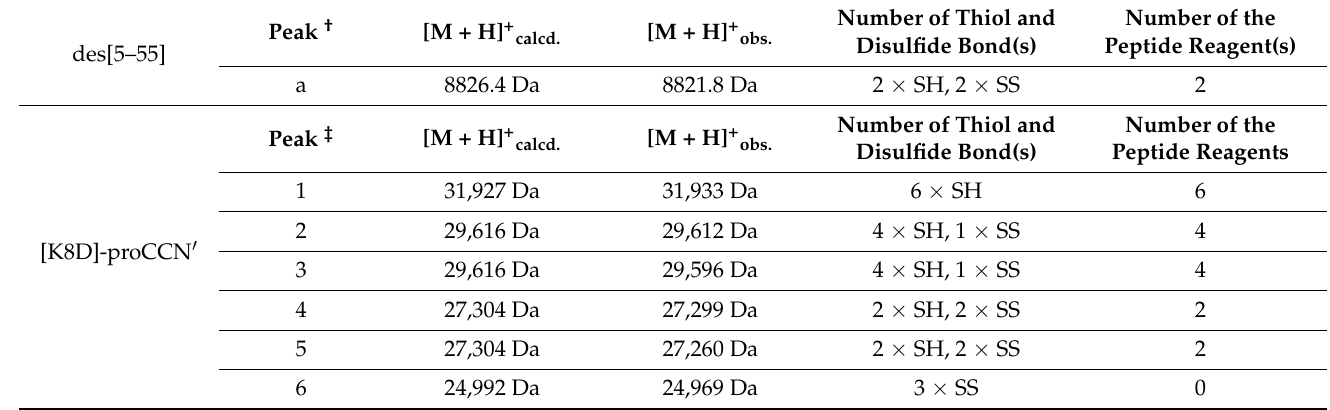
Table 1. The mass values of the folding intermediates * of BPTI and [K8D]-proCCN (cid:48) .